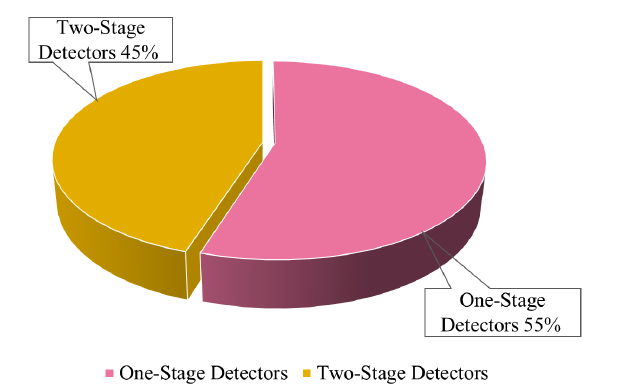
Figure 14. Comprehensive percentage division of DL approaches for handling problems in target detection.